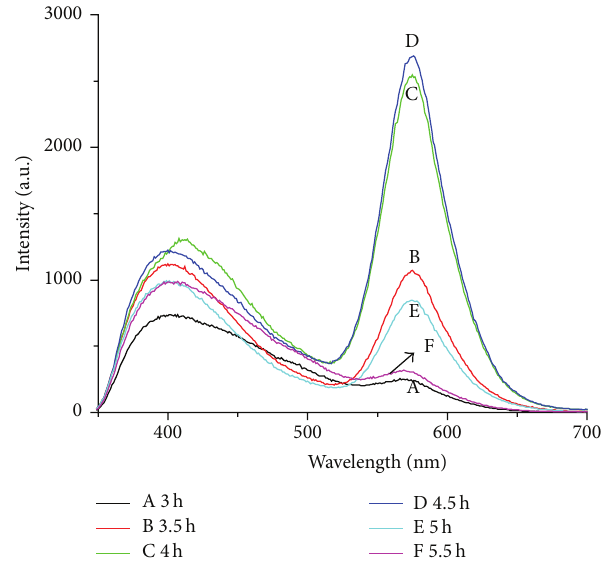
Figure 6: Fluorescence emission spectra of ZnS:Mn 2+ QDs under the different reaction temperature (from 30 ∘ C to 70 ∘ C), obtained using an excitation wavelength of 300nm.